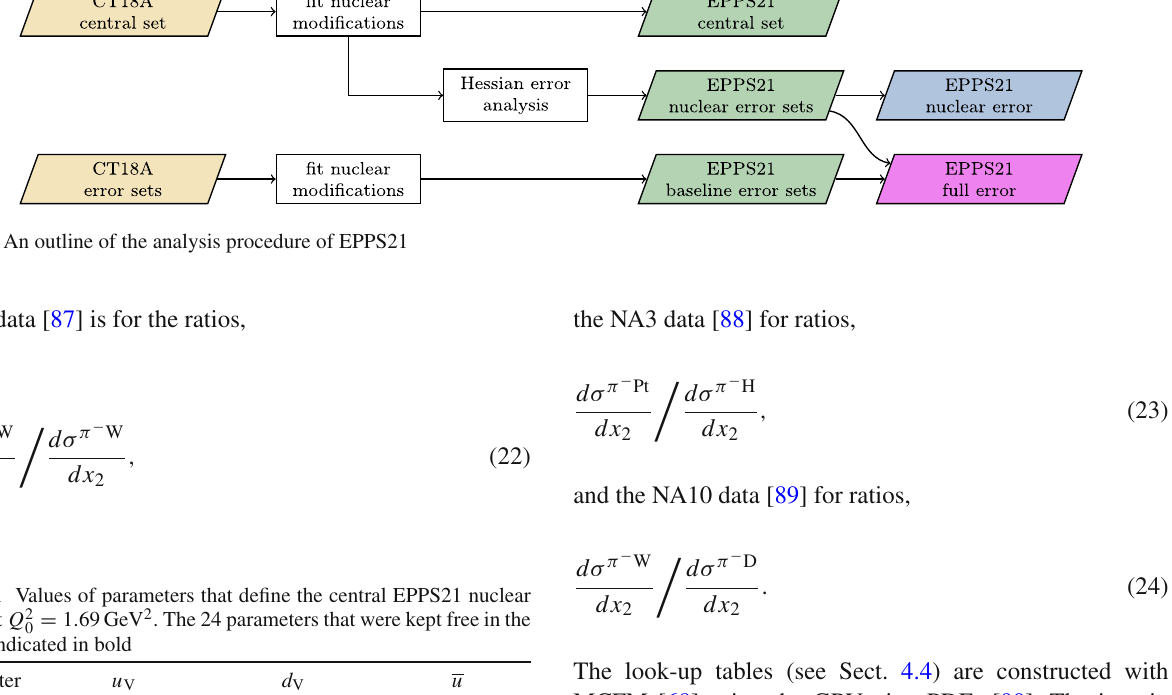
Fig. 4 An outline of the analysis procedure of EPPS21